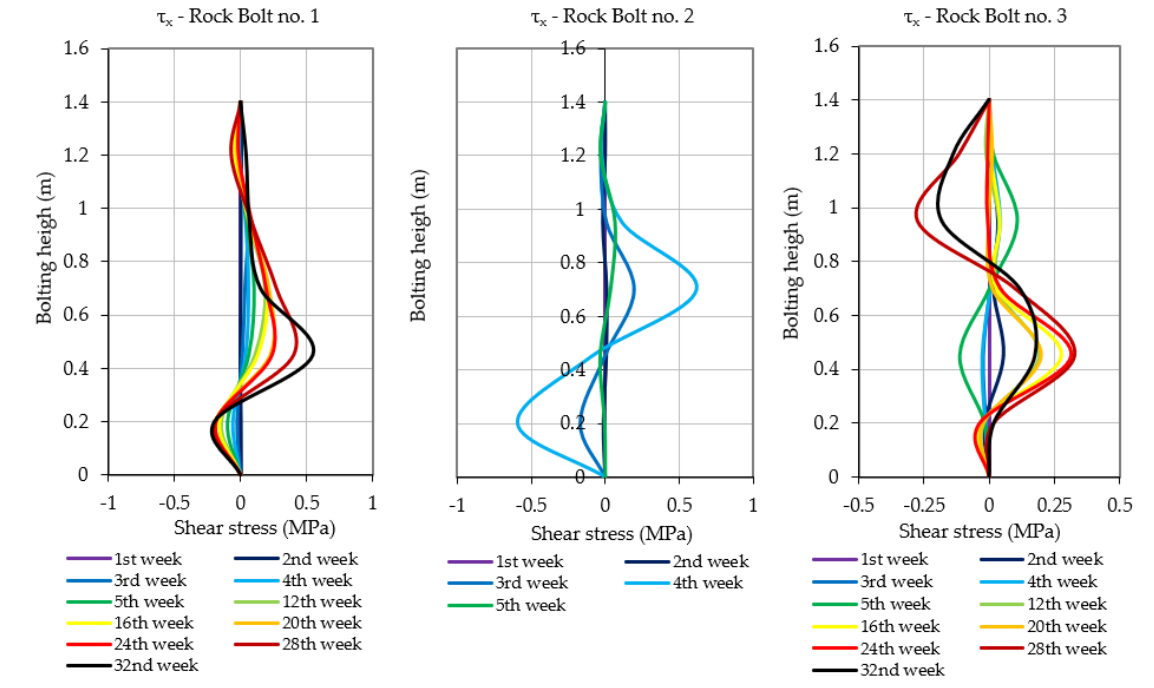
Figure 15. Shear stresses measured in rock bolts ’ bars during the underground measurements.